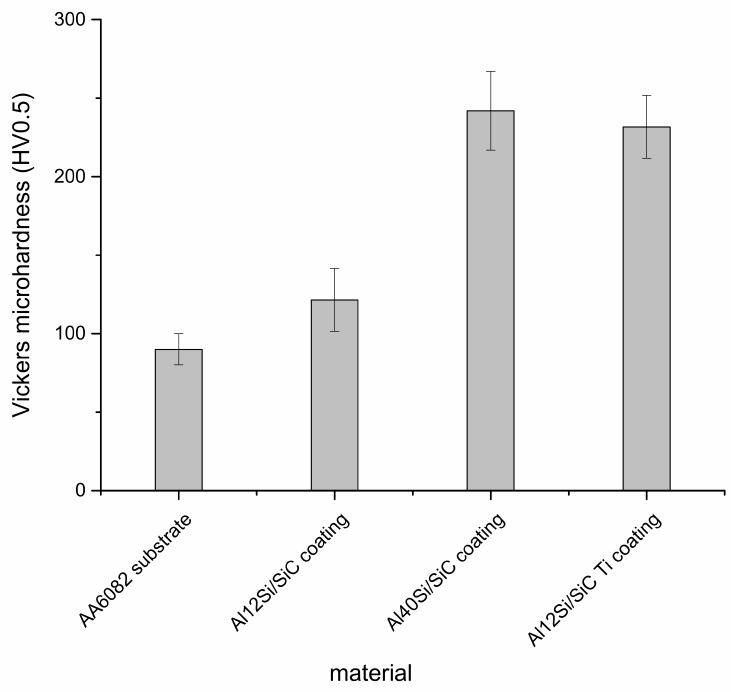
Figure 3. Microhardness measurements for the substrate and coatings on the AA6082 aluminum